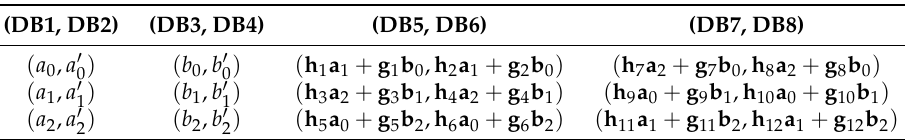
Table 12. Stored variables.